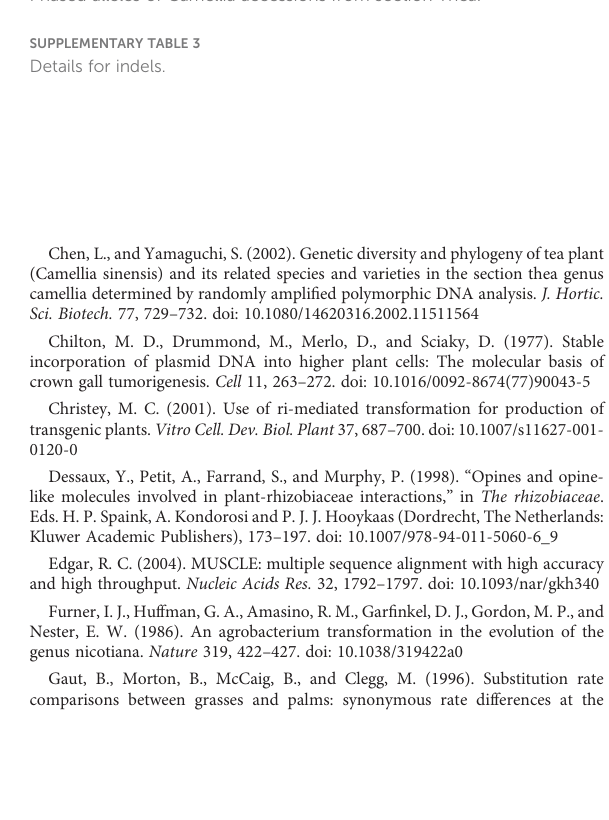
SUPPLEMENTARY TABLE 3 Details for